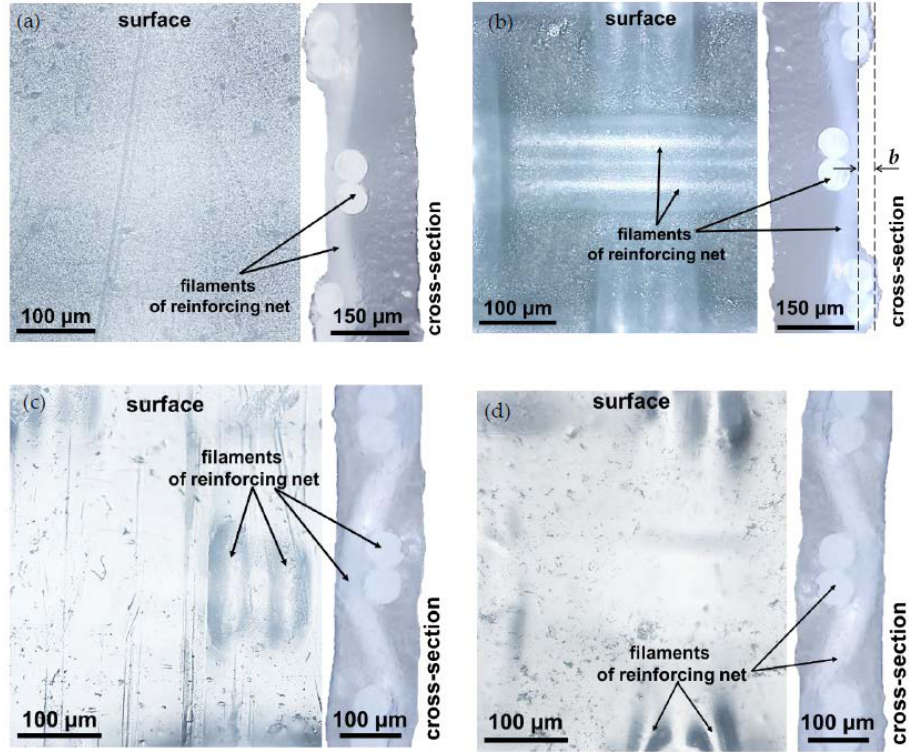
Figure 2. Optical images of the surface and cross sections of CJMC-3 ( a,b ) and CJMC-5 ( c,d ) membranes. Surface I is shown in figures ( a ) and ( c ); surface II is shown in figures ( b ) and ( d ). The explanations are in the text.